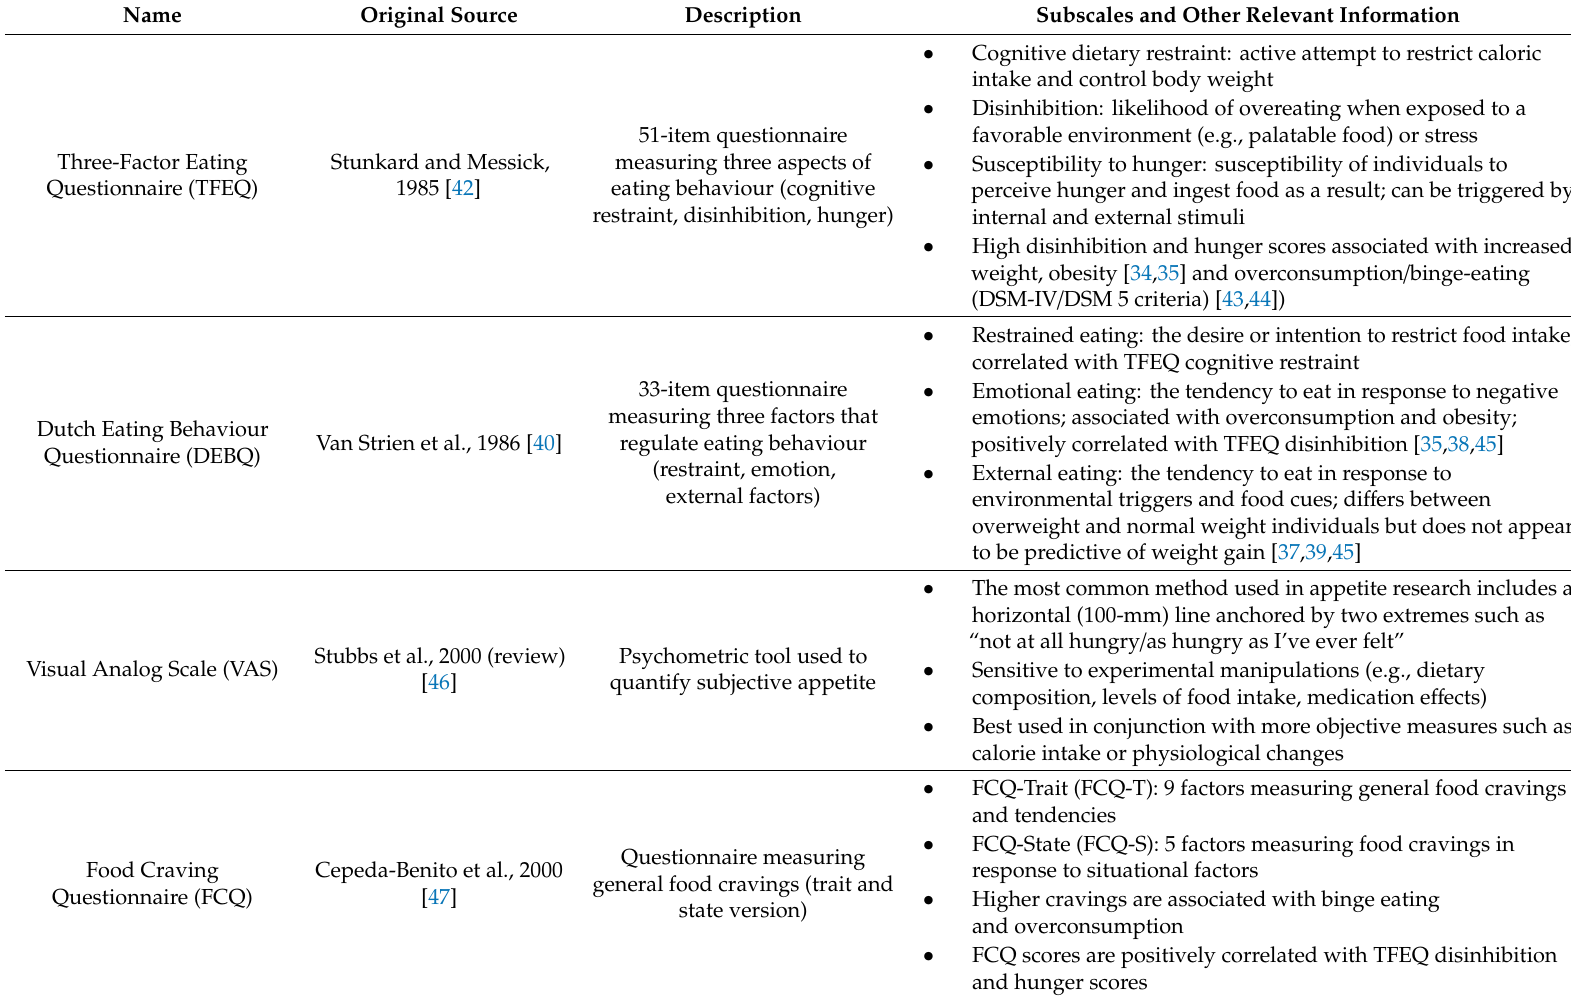
Table 3. Description of self-report questionnaires used to measure subjective appetite and eating behaviour; ‘Original Source’ indicates the authors who originally developed the